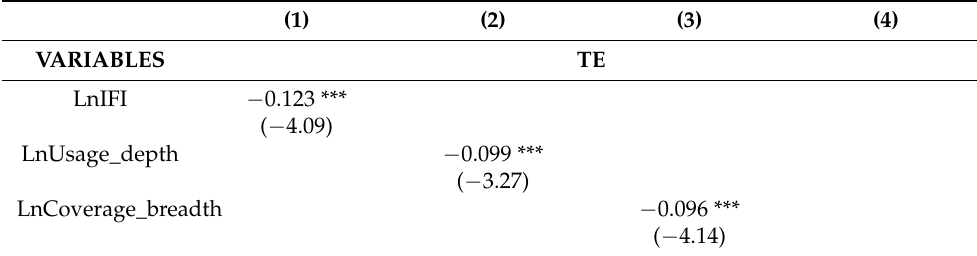
Table 11. Decomposition of financial